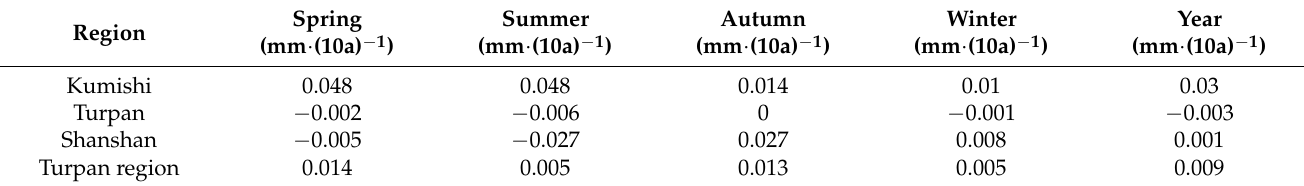
Table 2. Tendency rates of seasonal and annual precipitation changes in the Turpan region.